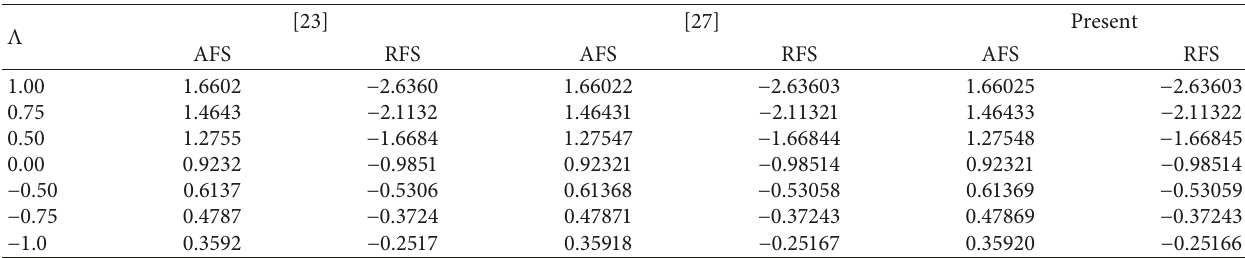
Table 2: Comparison of numerical values for different values of Λ for skin friction